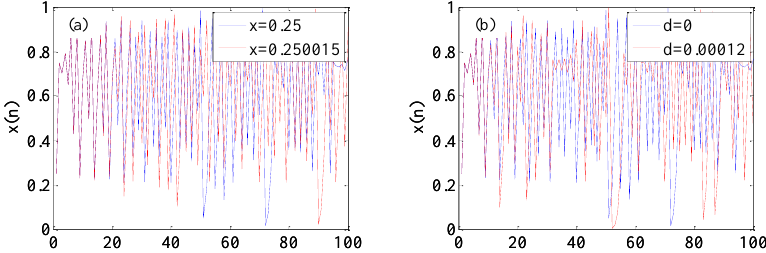
Figure 9. Sequences generated by enhanced logistic map using different initial values. ( a ) Initial values of 0.25 and 0.250015; ( b ) Initial values of 0 and 0.00012.